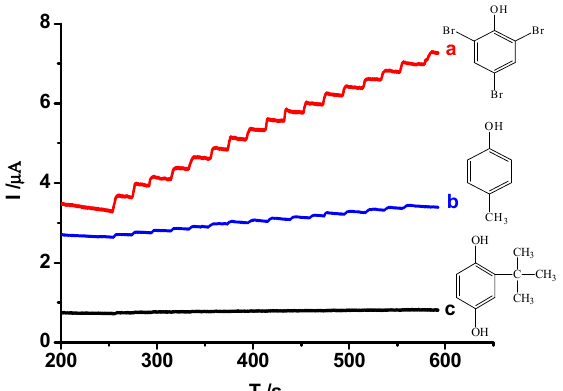
Figure 9. The amperometric i – t curve of MIP/Au in different solutions: (a) TBP; (b) 4-methyl-phenol; (c) tert-butylhydroquinone. (c) tert-butylhydroquinone.